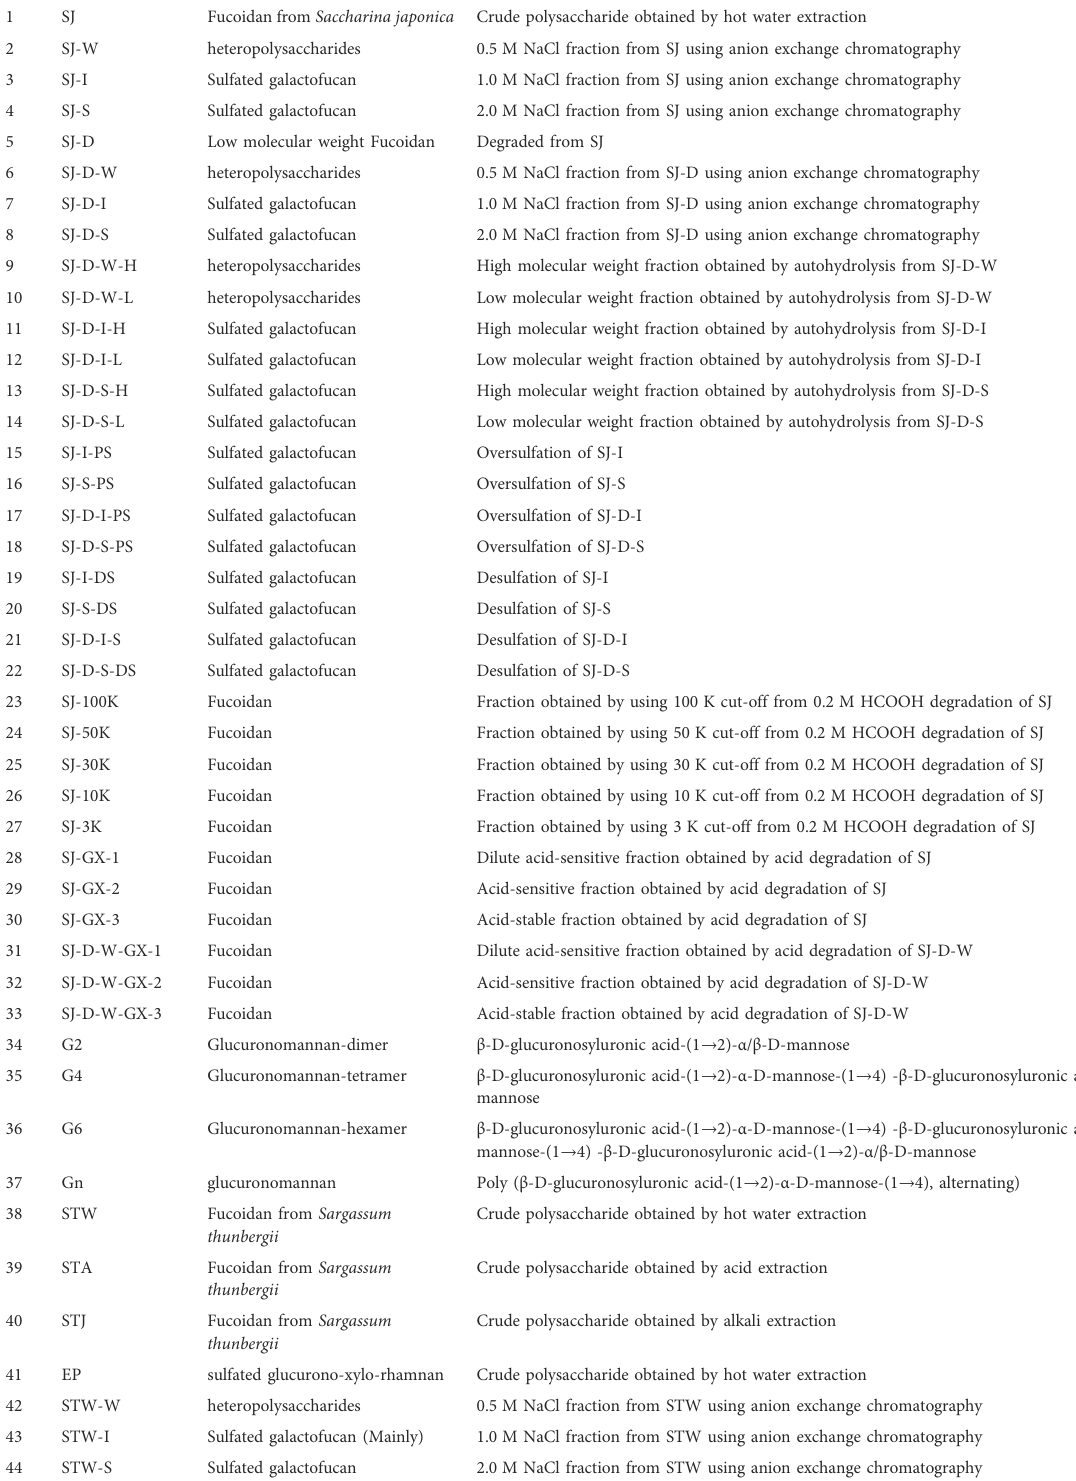
TABLE 1 Samples and their abbreviation in this